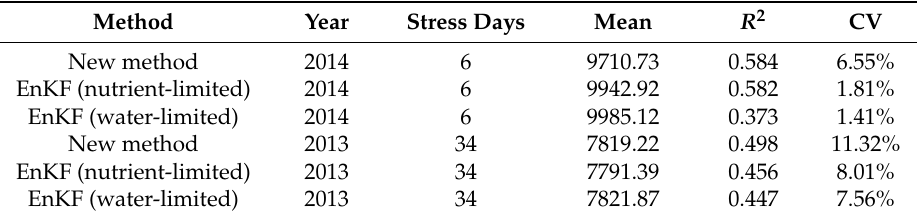
Table 9. Analysis results of the yields of Hongxing in 2013 and 2014 (kg/ha).